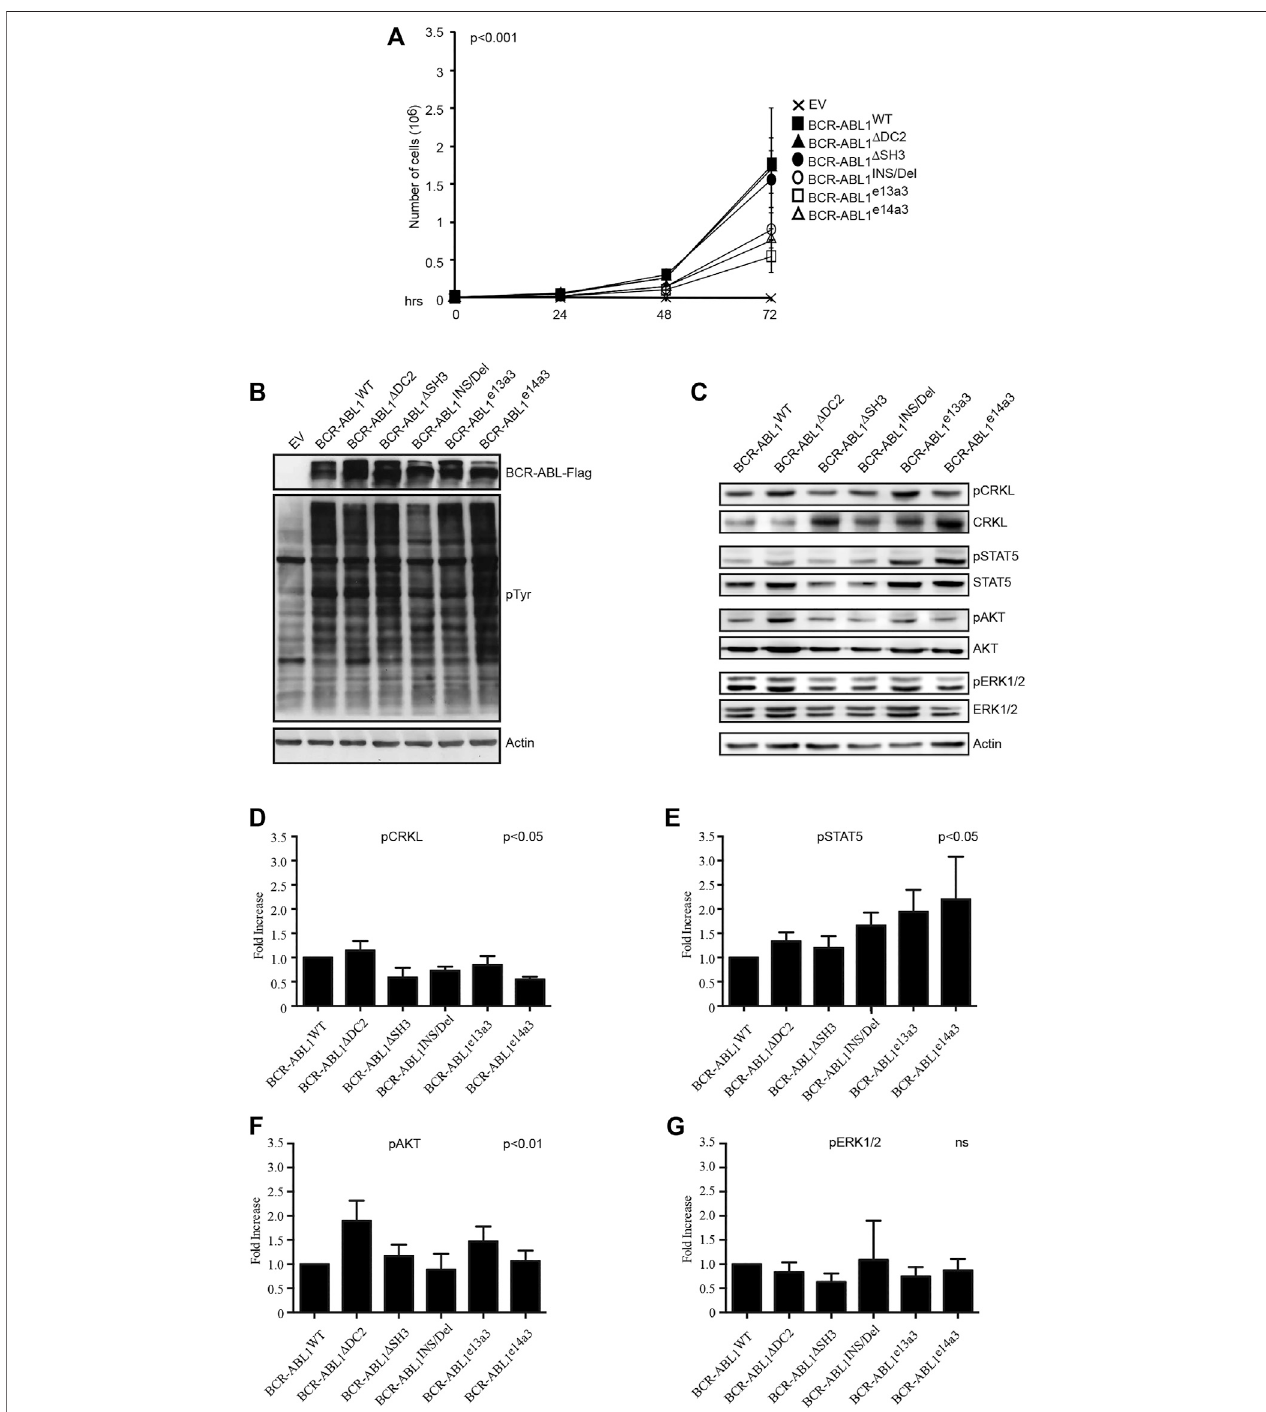
FIGURE2| AlterationsinthebreakpointregionmodifyBCR-ABL1-dependenttransformingabilityanddownstreamtargetphosphorylation. (A) Curvesindicatethe number of viable Ba/F3 cells transduced with the speci fi ed constructs as determined by the Trypan blue exclusion assay. Bars indicate standard deviation derived from three independent experiments performed in triplicates. (B , C) Immunoblots of protein lysates obtained from transduced Ba/F3 cells. Protein lysates were separated by SDS-PAGE, transferred to nitrocellulose membranes and hybridized with anti-FLAG, anti-posphtyrosine (B) or other antibodies recognizing the indicated total or phosphorylated protein (C) . For all immunoblots actin was used as loading control. (D – G) Histograms reporting the densitometric analysis for each indicated phosphorylated protein derived from the immunoblot showed in (B) employing the Image J software and arbitrarily setting the densitometric value of BCR-ABL1 WT at 1. The densitometric value of each total and phospho-protein was initially normalized to actin. The fi nal relative densitometric units were obtained by calculating the ratio between phosphorylated versus total protein fractions. Bars indicate standard deviations derived from two independent experiments.